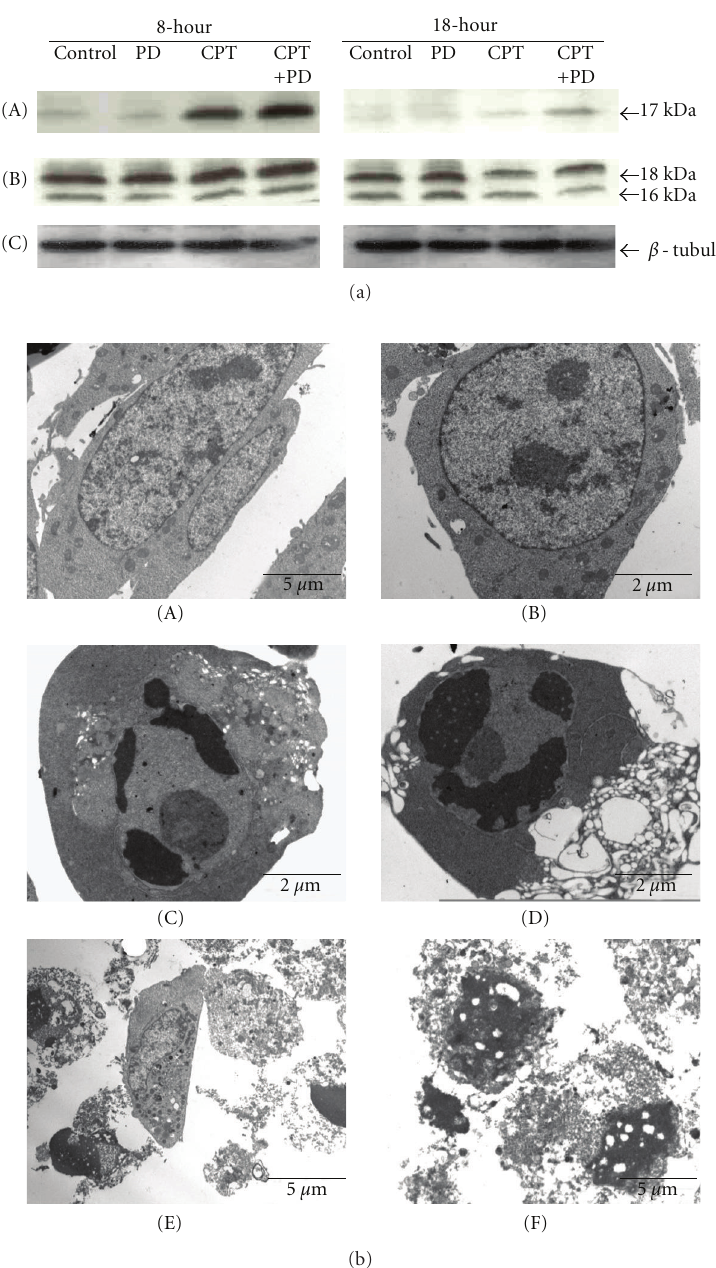
Figure 3: Inhibiting production of p25 does not alter the mode of cell death induced by CPT. (a) Western blot of equal amounts of protein samples from C8 cells treated with CPT or CPT + PD. (A) Cells exposed for 8hours or 18 hours showed the activation of caspase-3 (17kDa) by CPT both in the presence and in the absence of PD. (B): The expression of LC3-II, a 16kDa fragment indicating autophagy, did not change during the course of death in either control or experimental situations. (C) expression of β -tubulin demonstrated equivalent loading of protein samples. In summary, CPT marginally increases the activation of caspase 3 with or without PD but does not a ff ect the appearance of LC3-II. (b) C8 cells treated with CPT or CPT + PD for 8 or 18hours were fixed for electron microscopy. Untreated control C8 cells (A) and PD treated cells (B) were elongated and displayed large normal nuclei. Cells exposed to CPT in the absence ((C), (E)) or presence ((D), (F)) of PD showed features of apoptosis ((C) and (D)) after 8hours as well as vacuolization and secondary necrosis after 18 hours ((E) and